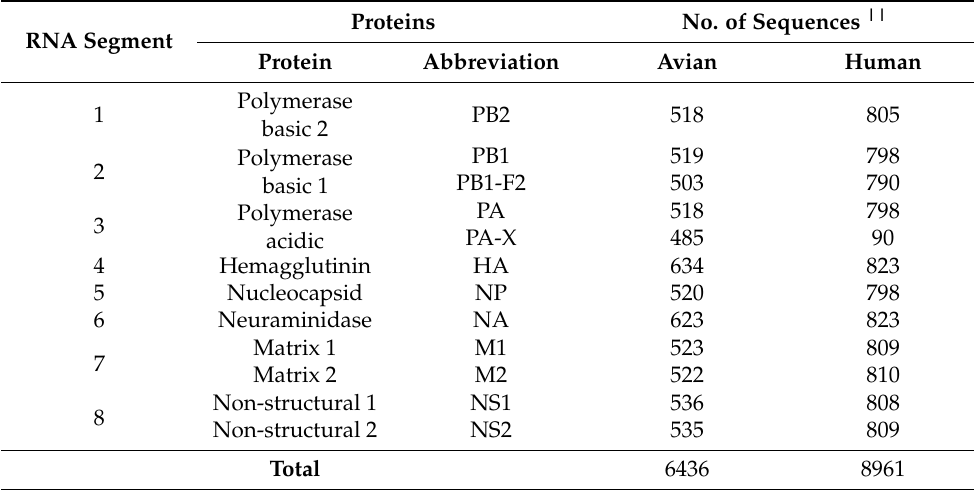
Table 2. Influenza A (H7N9) protein sequences from the 2017 dataset. RNA